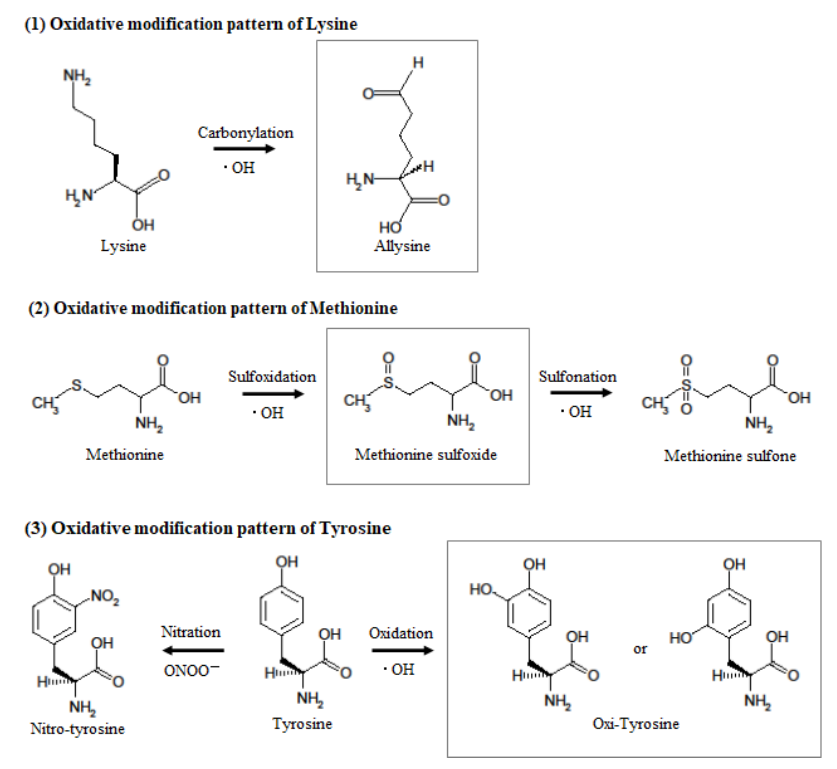
Figure 6. Hypothesized mechanism of oxidative modification of mouse serum albumin after sin- gle TBI. When tyrosine reacts with peroxynitrite or hydroxyl radicals, it becomes nitrotyrosine or hydroxytyrosine, but the aromatic substituent pattern cannot be identified by mass spectrometry. When methionine reacts with hydroxyl radicals, it becomes methionine sulfoxide and then methionine sulfone. When lysine reacts with hydroxyl radicals, it becomes